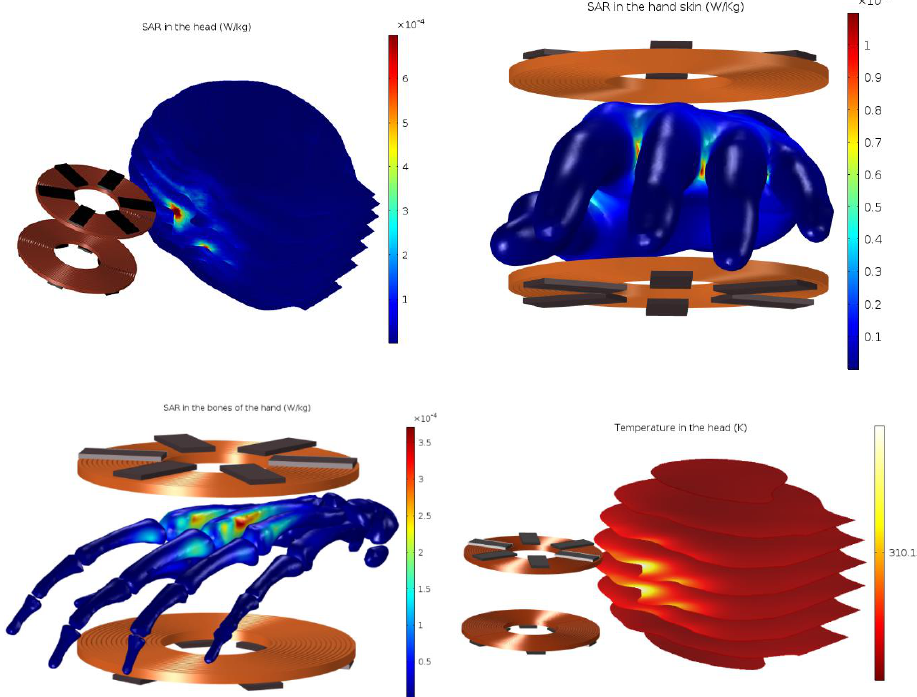
Figure 7. Specific absorption rate ( SAR ) in W / kg of the head, skin and bones of the hand; temperature increasing in the head.